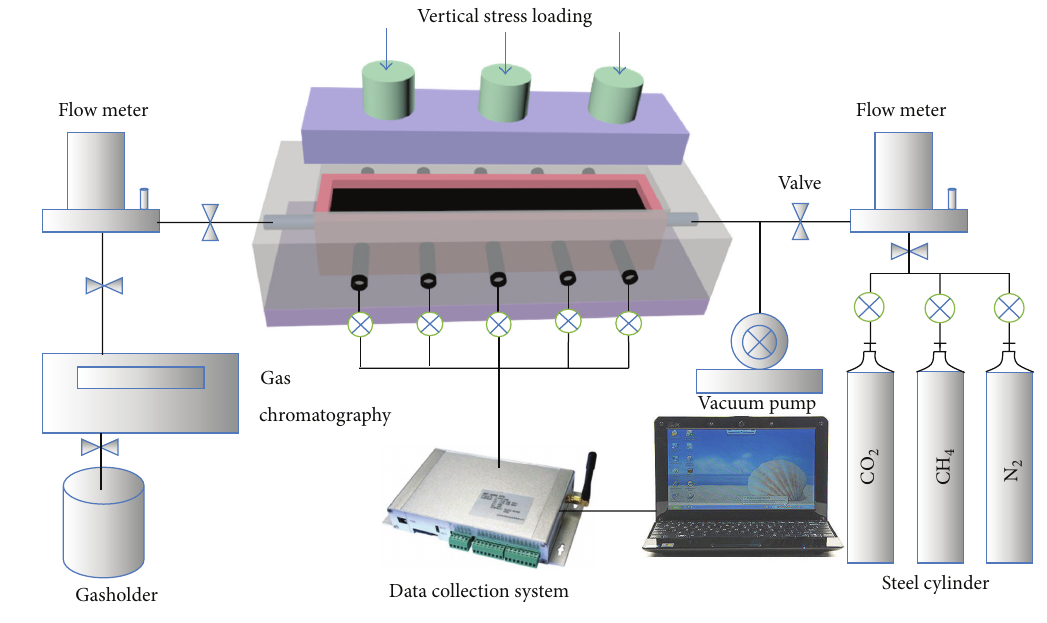
Figure 1: Schematic diagram of experimental setup.